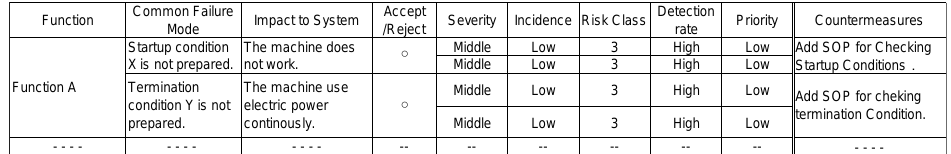
Figure 2. The procedure of the proposed failure mode and effects analysis (FMEA). Table 2. Sample of failure mode and effects analysis (FMEA) sheet.